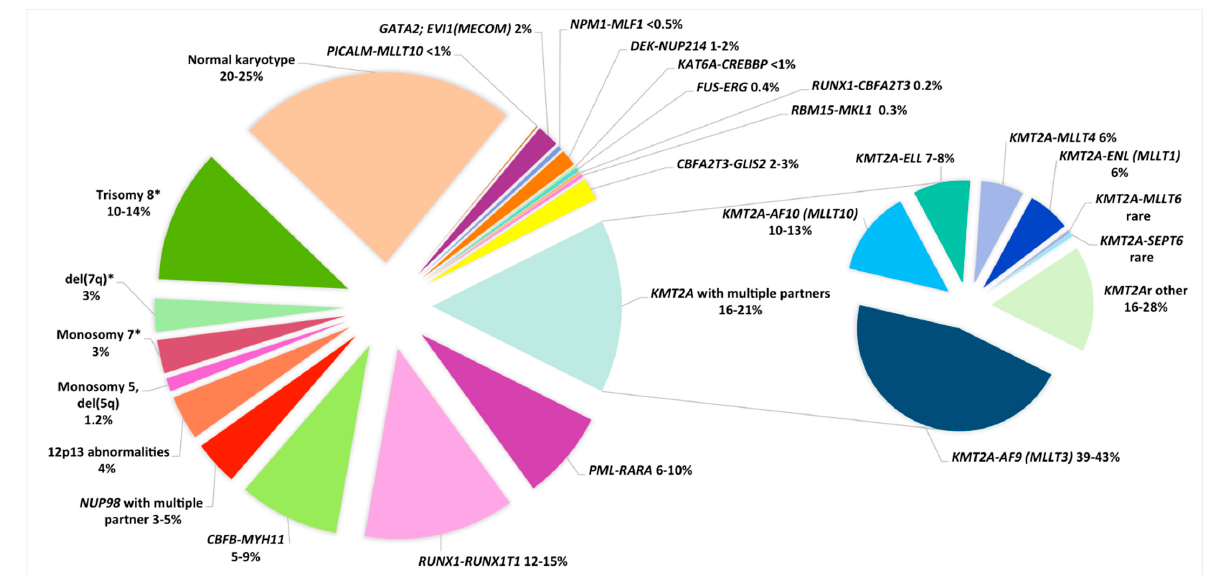
Figure 1. Distribution of cytogenetic subgroups in pediatric AML. * As a sole abnormality.